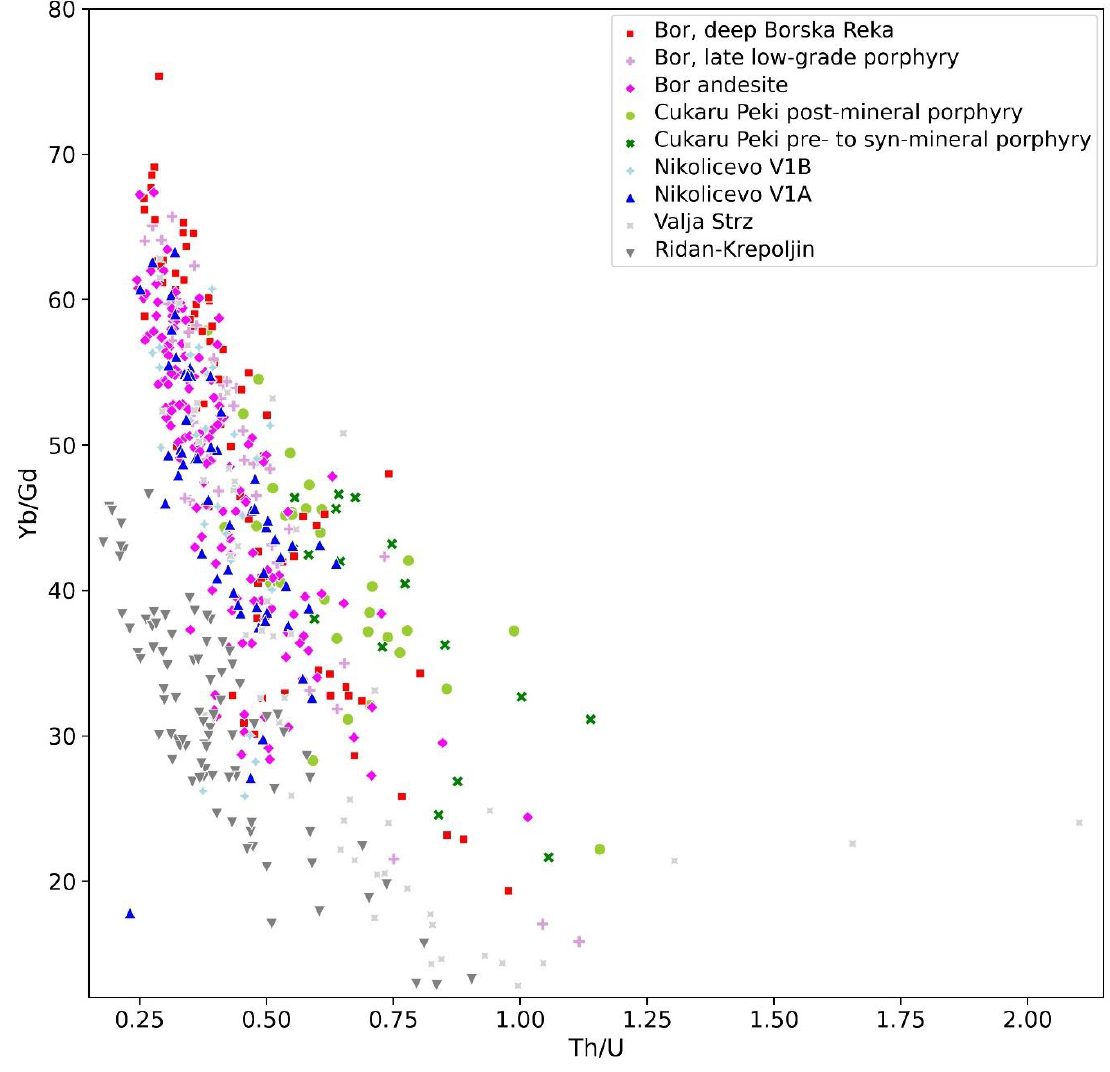
Figure 14. Yb/Gd vs. Th/U diagram, showing the fractionation trend for Bor and the evidence of magma mixing for Cukaru Peki, and the separation between mineralized and barren